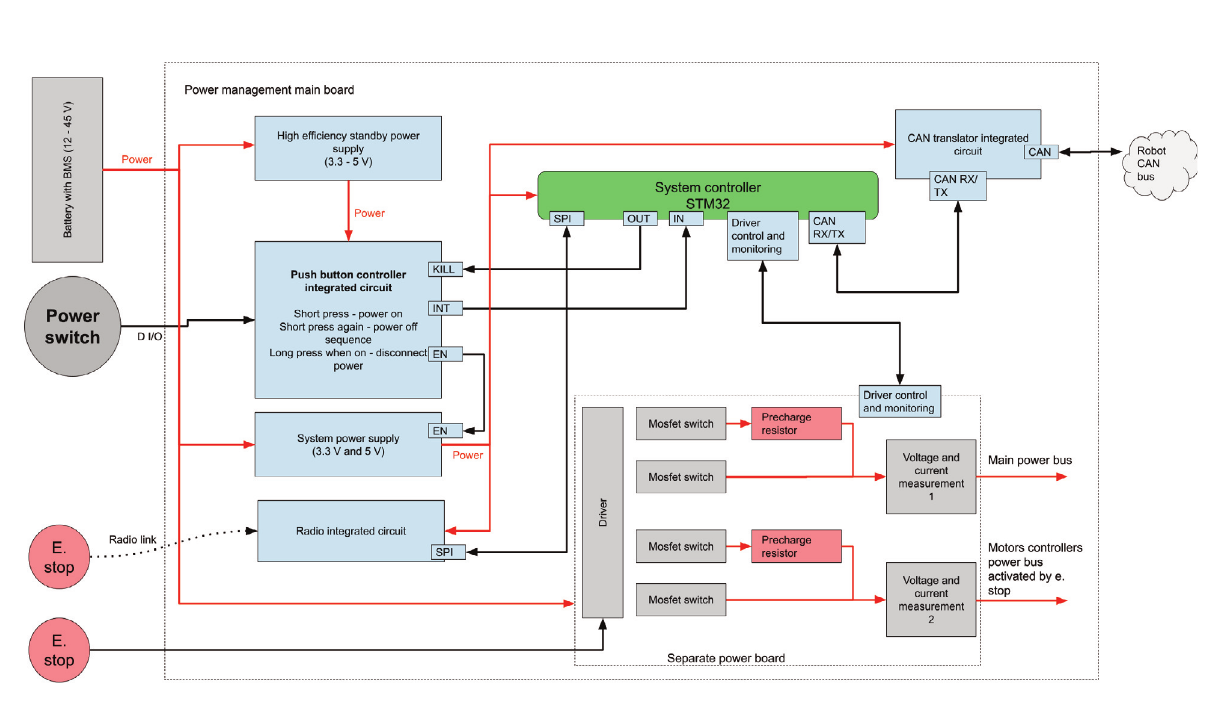
Fig. 3. New power management and safety solution for TalTech BoxBot. SPI – serial peripheral interface; INT – interrupt; EN – enable; RX – receive; TX –